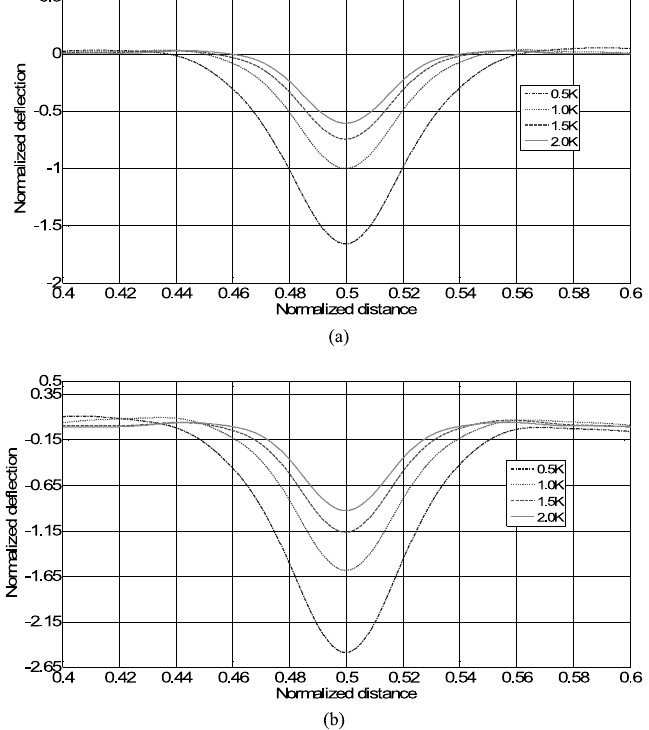
Fig. 7. Effect of foundation stiffness on dynamic de fl ection responses at a constant speed of 88.25 km/h; (a) moving load (b) moving